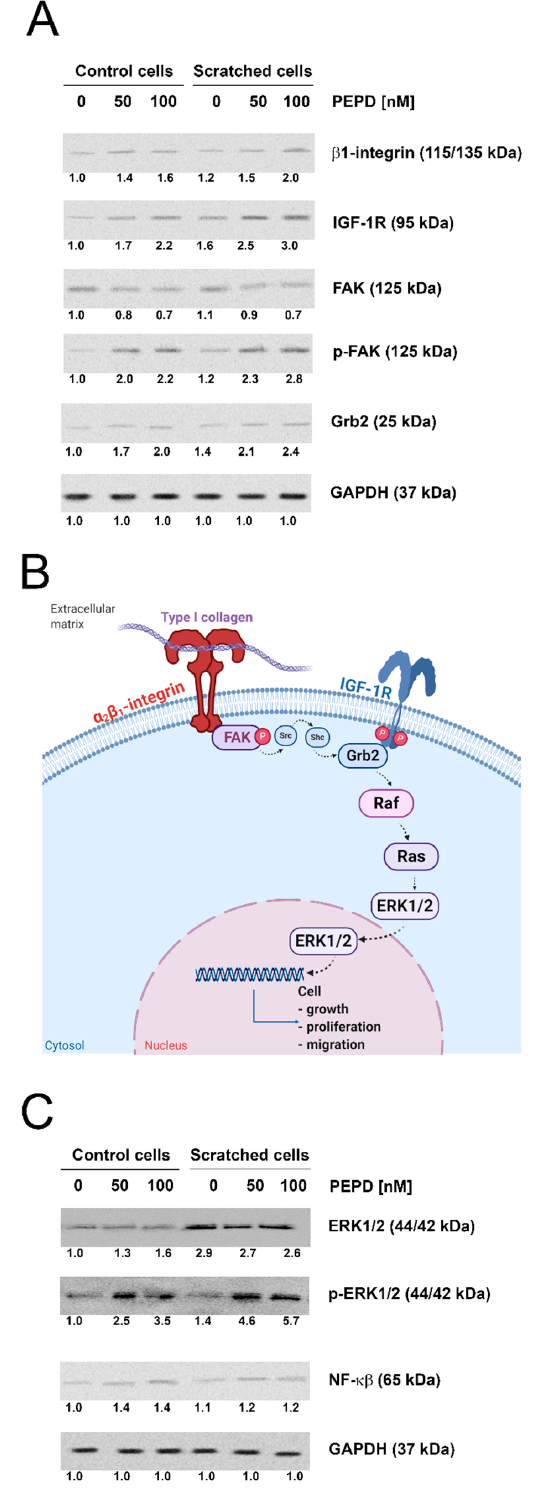
Figure 4. Extracellular PEPD induced expression of the β 1 -integrin receptor and IGF-1R signaling proteins in control and “scratched” fibroblast models. ( A ) The proteins of β 1 -integrin receptor and IGF-1R downstream signaling pathways, FAK, Grb2, and ( C ) NF-k β and ERK1/2 were analyzed by Western blot in lysates of PEPD-treated fibroblasts (50, and 100 nM). Representative blot images were shown (densitometry of protein stains is presented under protein bands as a ratio versus control; Supplementary Figure S2). GAPDH was used as a loading control. ( B ) Illustration of the β 1 -integrin receptor-downstream signaling pathway. Created with